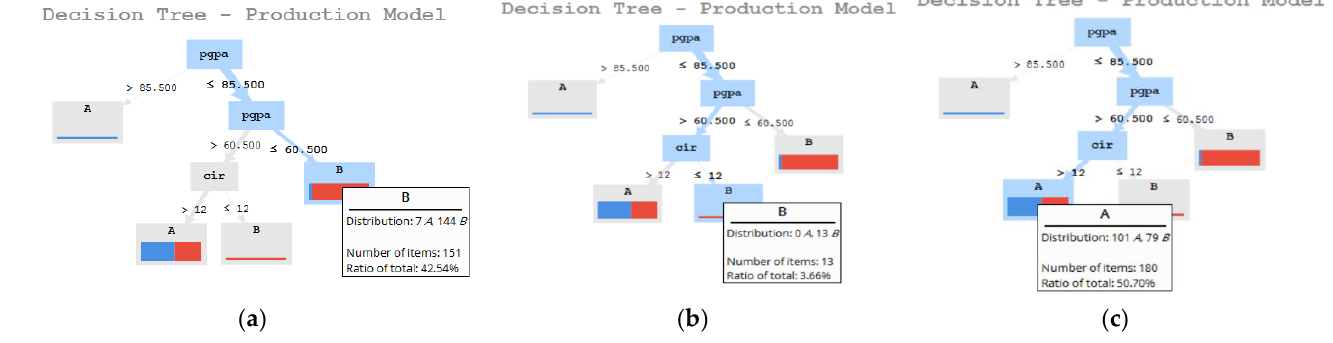
Figure 5. Classification Decision Tree at M1: ( a ) pgpa <= 60.5; ( b ) pgpa between (60.5, 85.5) and cir <= 12; ( c ) pgpa between (60.5, 85.5) and cir > 12.